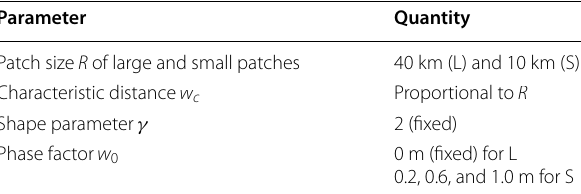
Table 3 Variables for the two-patch case Parameter Quantity Patch size R of large and small patches 40 km (L) and 10 km (S) Characteristic distance w